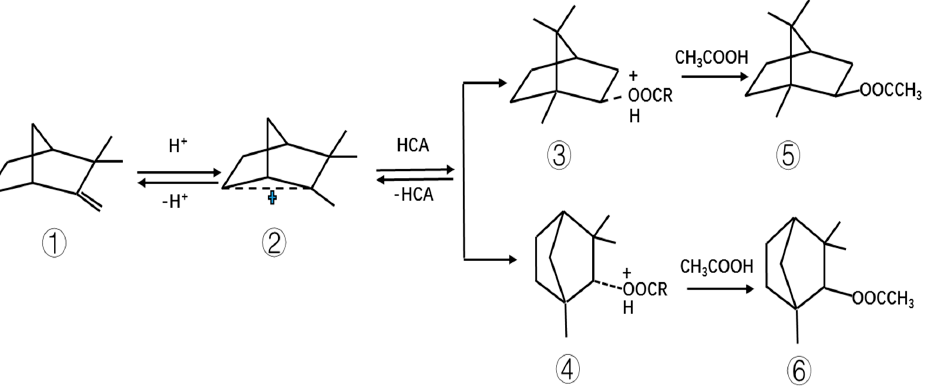
Figure 8. Mechanism of camphene reaction with acetic acid. Note: ① camphene, ② carbocation, ③ oxonium ion “isobornyl hydroxylate,” ④ oxonium ion “fenchyl hydroxylate,” ⑤ isobornyl acetate, ⑥ fenchyl acetate. R represents the alkyl group of HCA.